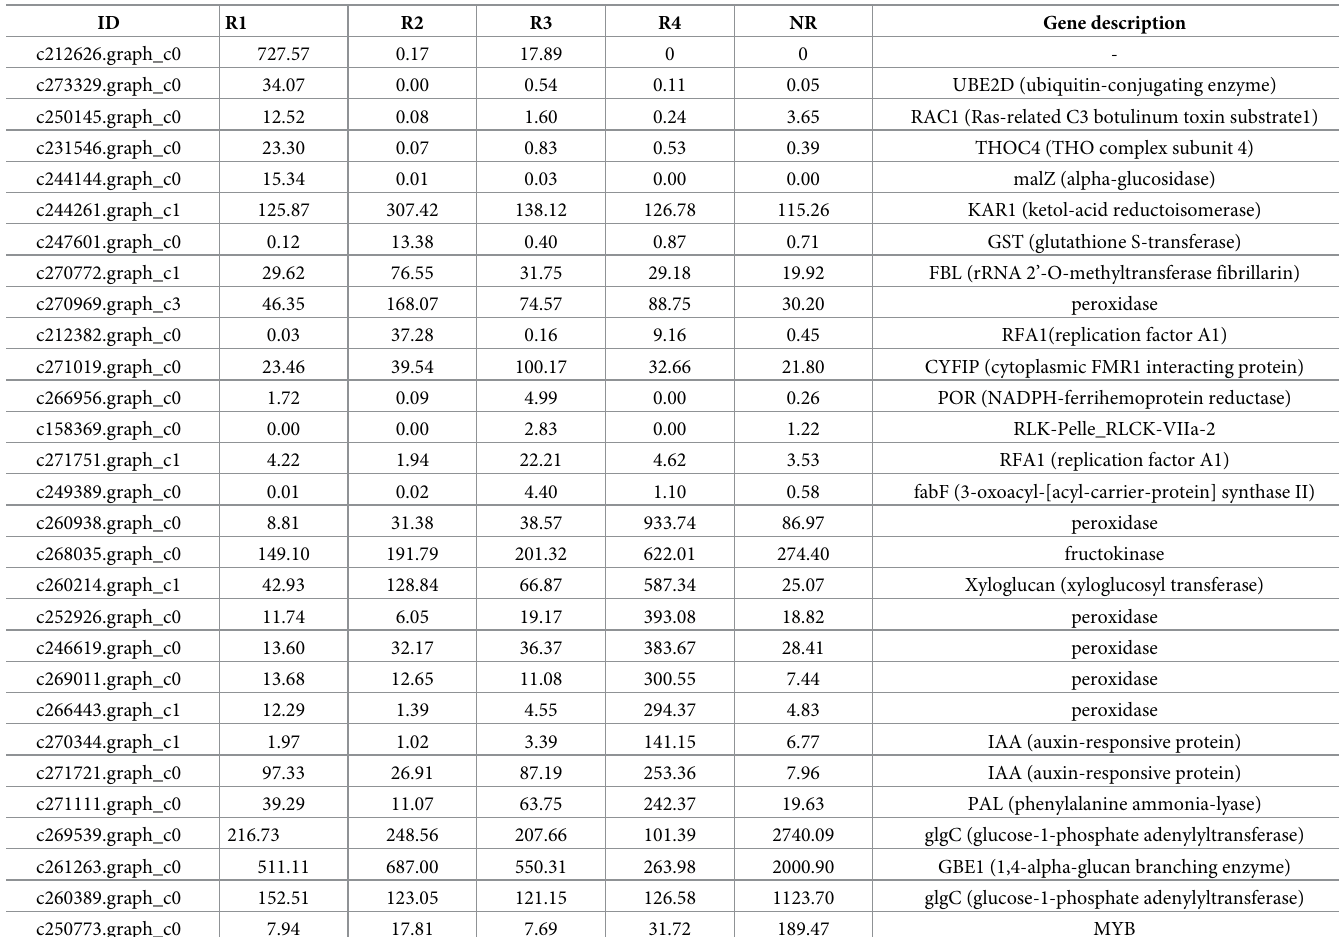
Table 2. Statistical data of genes with higher expression in each